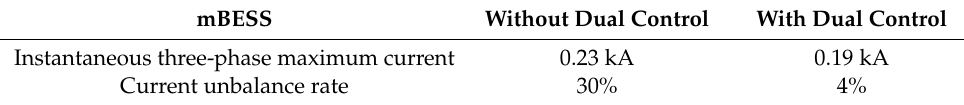
Table 2. Instantaneous current and current unbalance rate of the mBESS.